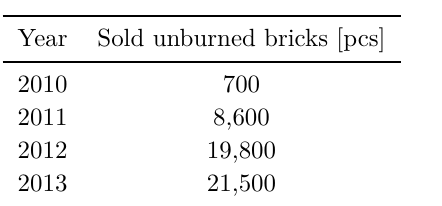
Table 1. Number of sold unfired bricks of Heluz company [7].